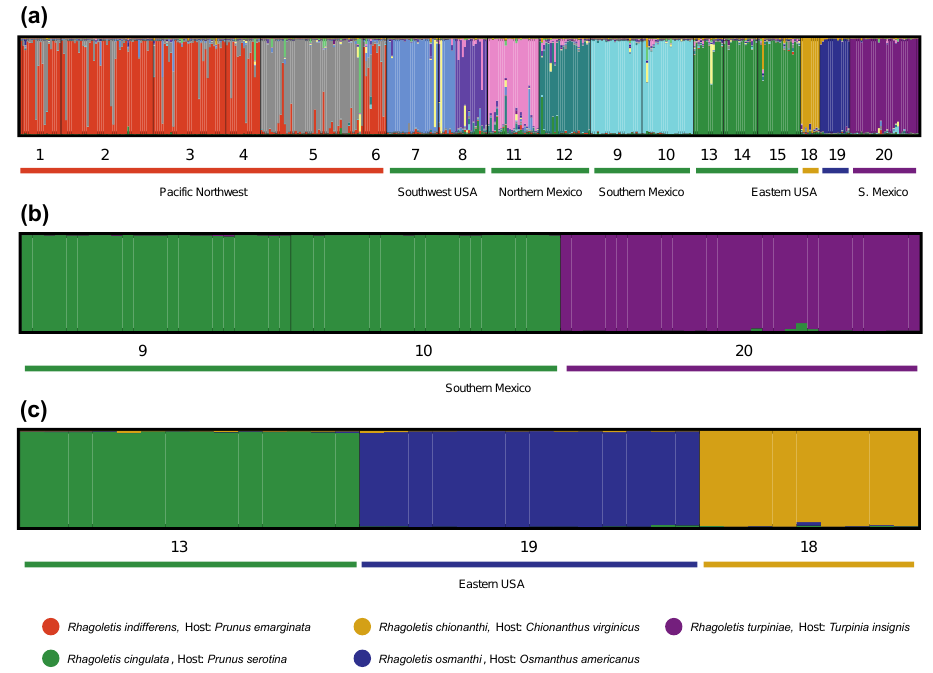
Figure 3. STRUCURE plots based on microsatellites for: ( a ) all R. cingulata group flies across North America with the best fit K = 13 subpopulations, as determined by the method of Pritchard et al. [50]; ( b ) Southern Mexican populations of R. cingulata (sites 9 and 10) and R. turpiniae (site 20) with the best fit K = 2, as determined by the method of Evanno et al. [52]; and ( c ) Southeastern USA populations of R. cingulata (site 13), R. chionanthi , (site 18), and R. osmanthi (site 19) with the best fit K = 3 [52].